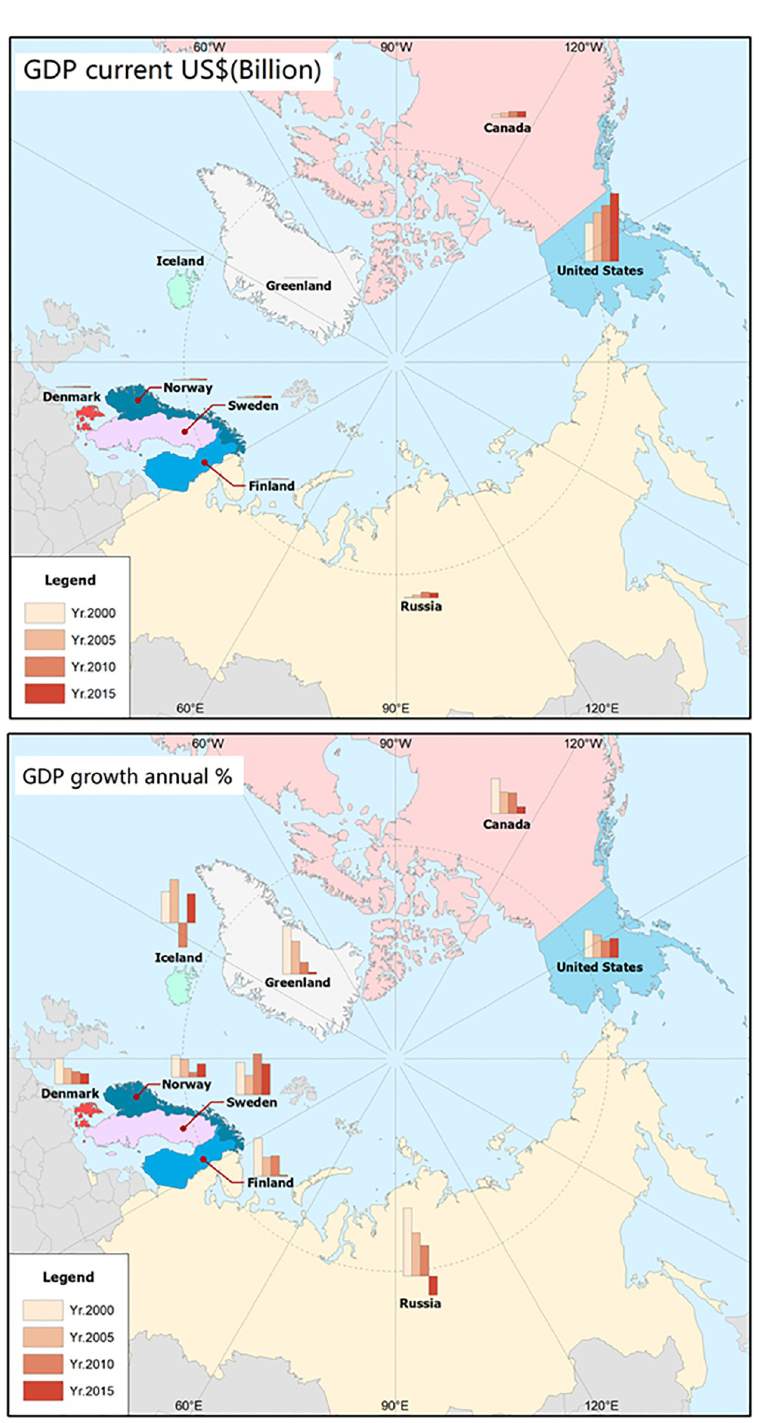
Fig 4. Geoeconomic characteristic spatial match, taking GDP and GDP growth as examples. The boundary was obtained from Natural Earth (http://www.naturalearthdata.com/).